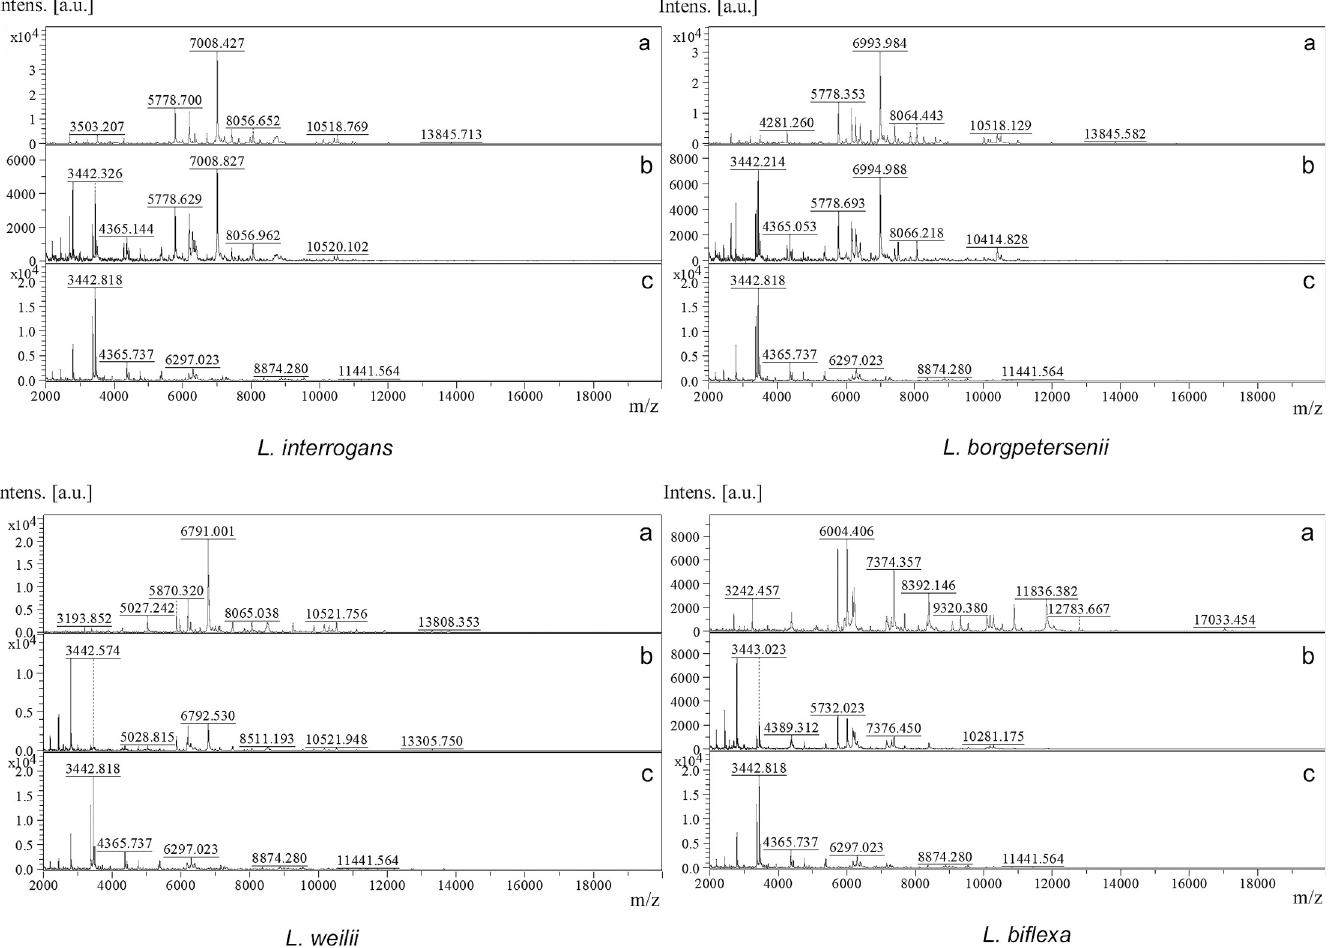
Fig 4. The protein profile matching of spiked leptospires in urine and media. The protein spectra of L . interrogans , L . borgpetersenii , L . wolffii and L . biflexa in culture media (a), spiked in urine (b). Urine without any leptospires used as control (c).